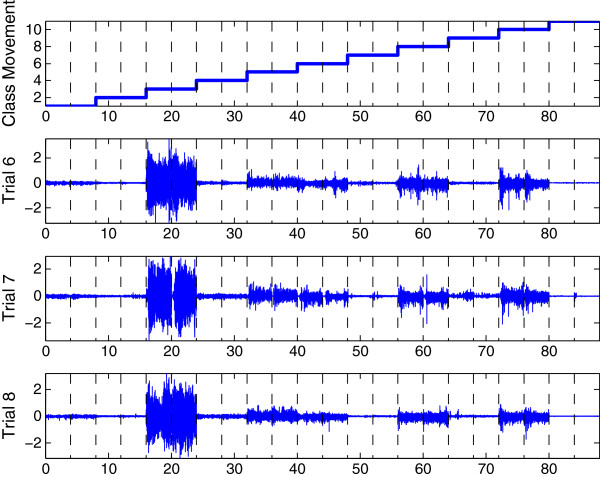
Acquired signal with the sequence of movements from 1 to 11. Signals illustrated correspond to channel 3 during trials 6 to 8 and user 1. Dotted lines indicate the held time for the contraction (4 s). Note that the movements were evaluated in sequential ascending order for all trials.